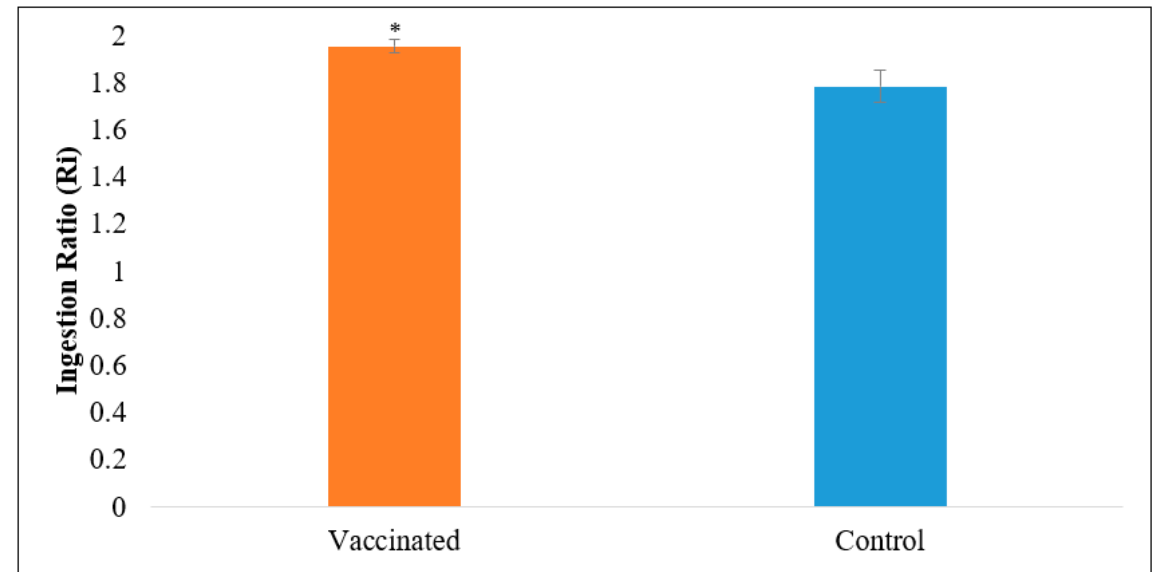
Figure 3. The ingestion ratio of vaccinated and commercial feed for Asian seabass, Lates calcarifer (mean ± SE, n = 15). Asterisks indicate a significant difference ( p < 0.05) from the control.